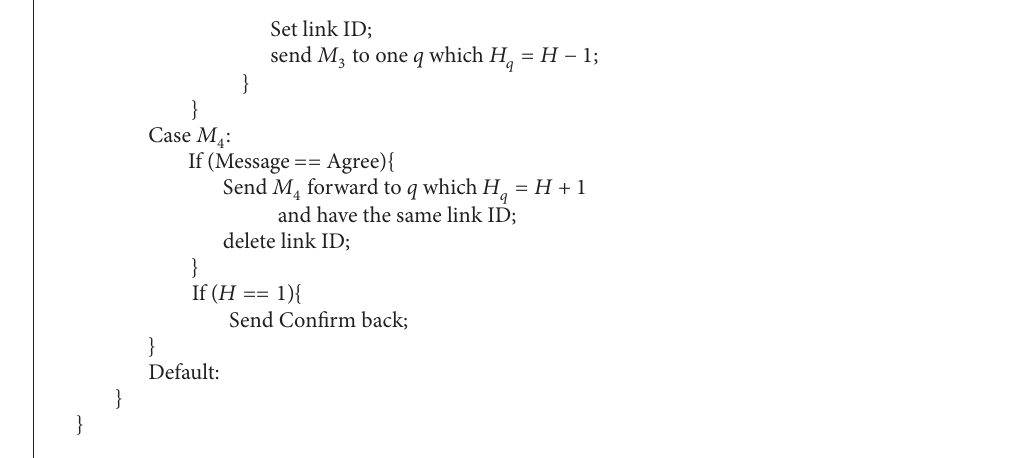
Algorithm 1: Algorithm of taxi node.